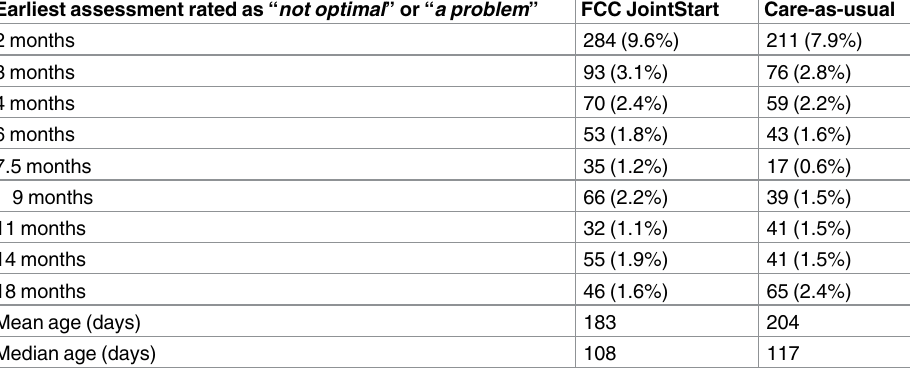
Table 3. Overview of the earliest assessment rated as “ not optimal ” or “ a problem ” per child, as com- pared to all children participating, in the Family-centered care approach (FCC-JointStart) and Care- as-usual